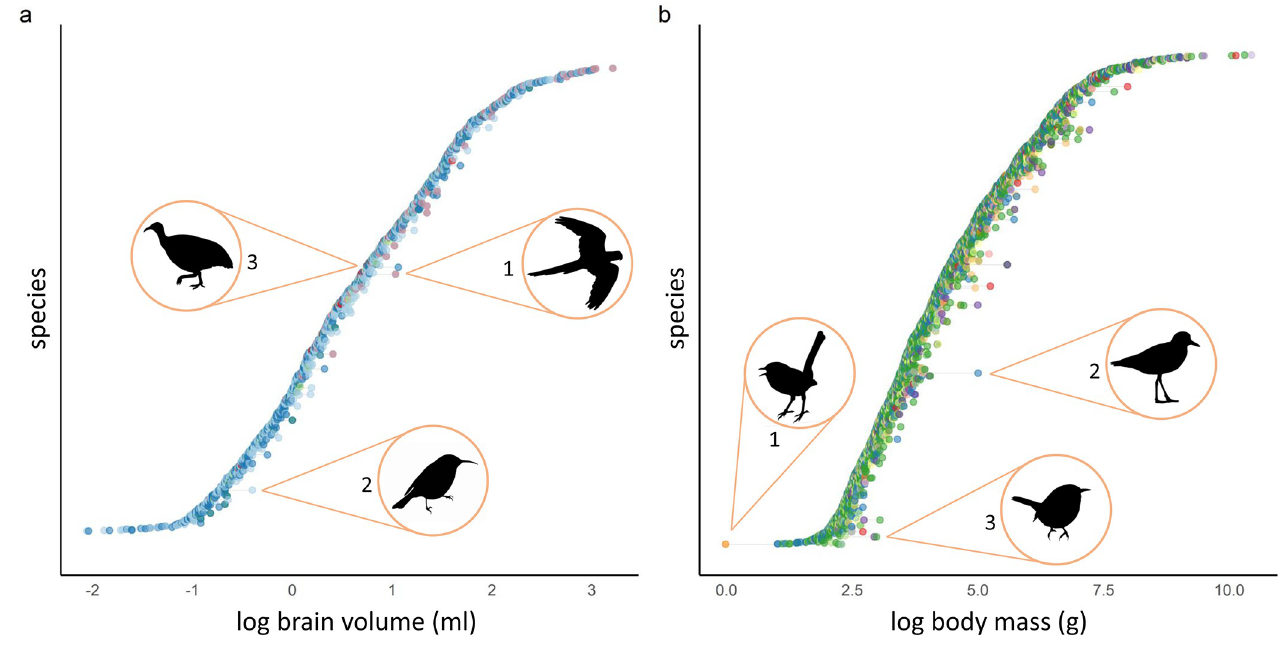
Fig 1. Across datasets, some species varied considerably in brain size estimate (Fig 1A). For instance, the minimum and maximum brain size estimates of the maroon-bellied parakeet ( Pyrrhura frontalis ) (with the largest overall difference in estimates) overlapped with the brain size estimates of 159 other species in our full sample of 1473 species (thus, the brain size of this species spanned 10.79% of the species in our sample, depending on the dataset used). Similarly, the eastern spinebill’s ( Acanthorhynchus tenuirostris ) minimum and maximum estimates (with the second largest difference) overlapped with 150 species (10.18% of our sample) and the great tinamou’s ( Tinamus major ) estimates (the third largest difference) overlapped with 141 species (9.57% of our sample). Variation was not driven by any one dataset in particular (Fig 1A). Our collated body size dataset contained 2331 species from eleven datasets. 1599 of these species had body mass measurements in more than one dataset. There was a general paucity of details for body mass data. Only one of 11 studies explicitly reported the number of samples from which body mass estimate was calculated [51]. Only two of 11 explicitly stated that body mass estimates were sex-averaged [53, 54]. Ten of the eleven datasets recorded both brain size and body mass data; however, only three of these sometimes collected body mass from the same specimens as brain size [18, 46, 55] and only two always collected body mass from the same specimens as brain size [21, 51]. Three studies did not mention the primary sources of the body mass data used [48, 52, 53]. Fig 1B visualises variation in log-transformed body mass estimates across datasets. Again, some species varied considerably in body mass estimates. For instance, the minimum and maximum body mass estimates of the blue-breasted fairywren ( Malurus pulcherrimus ), with the largest overall difference in estimates, overlapped with the body mass estimates of 140 other species in our full sample of 2331 species (6.01%). Similarly the three-banded plover’s ( Charadrius tricollaris ) minimum and maximum estimates (with the second largest difference) overlapped with 759 species (32.56% of our sample), and the Carolina wren’s ( Thryothorus